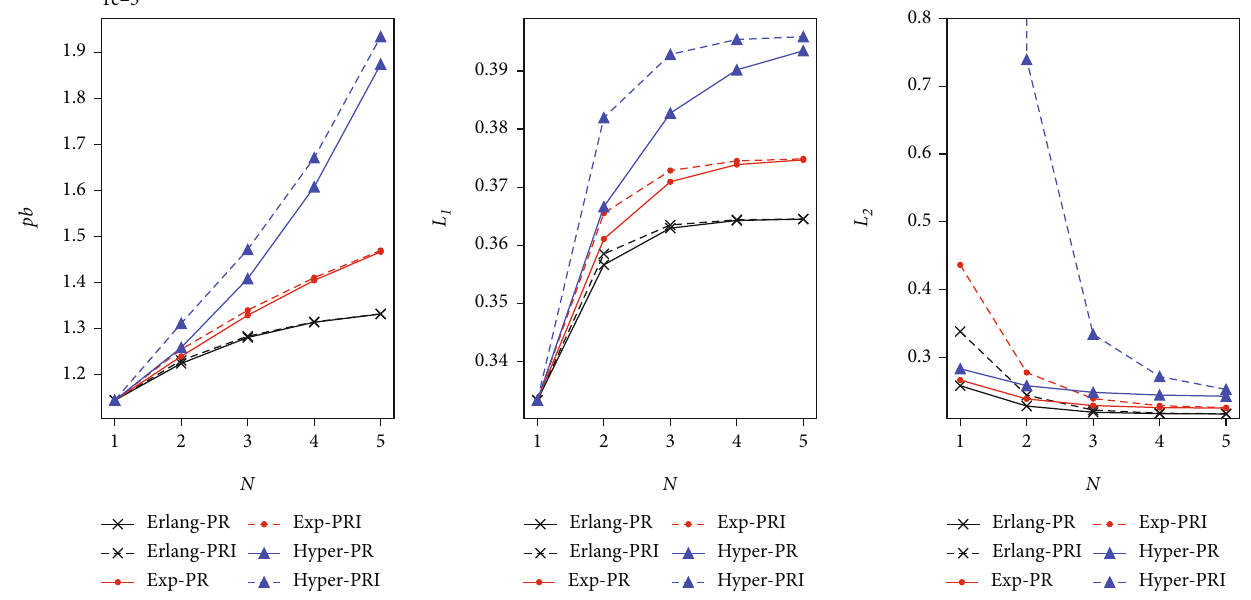
Figure 1: Performance measures for various values of N